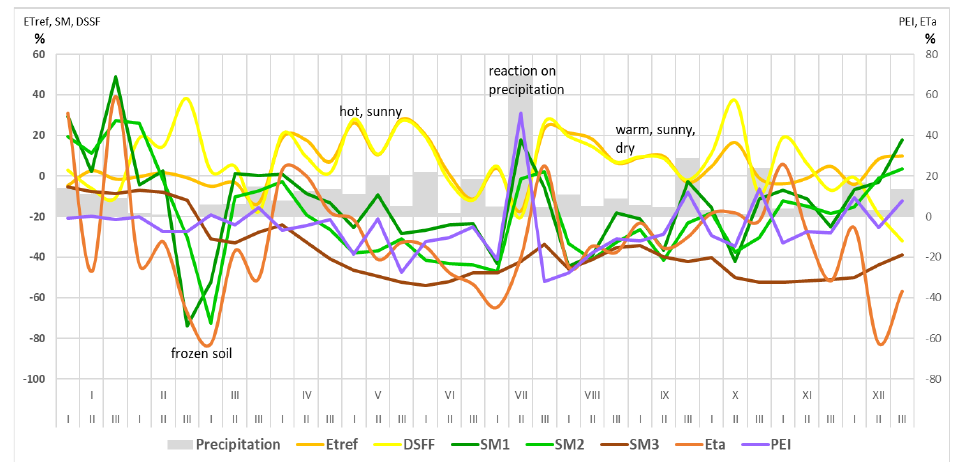
Figure 8. Course of anomalies of selected indices relative to precipitation totals in Wielkopolskie Province in 2018. Etref: reference evapotranspiration, DSFF: down-welling surface short-wave radiation; SM1: soil moisture 0 – 7 cm; SM2: soil moisture 7 – 28 cm; SM3: soil moisture 28 – 100 cm; Eta: actual evapotranspiration, PEI: Precipitation-Evapotranspiration.